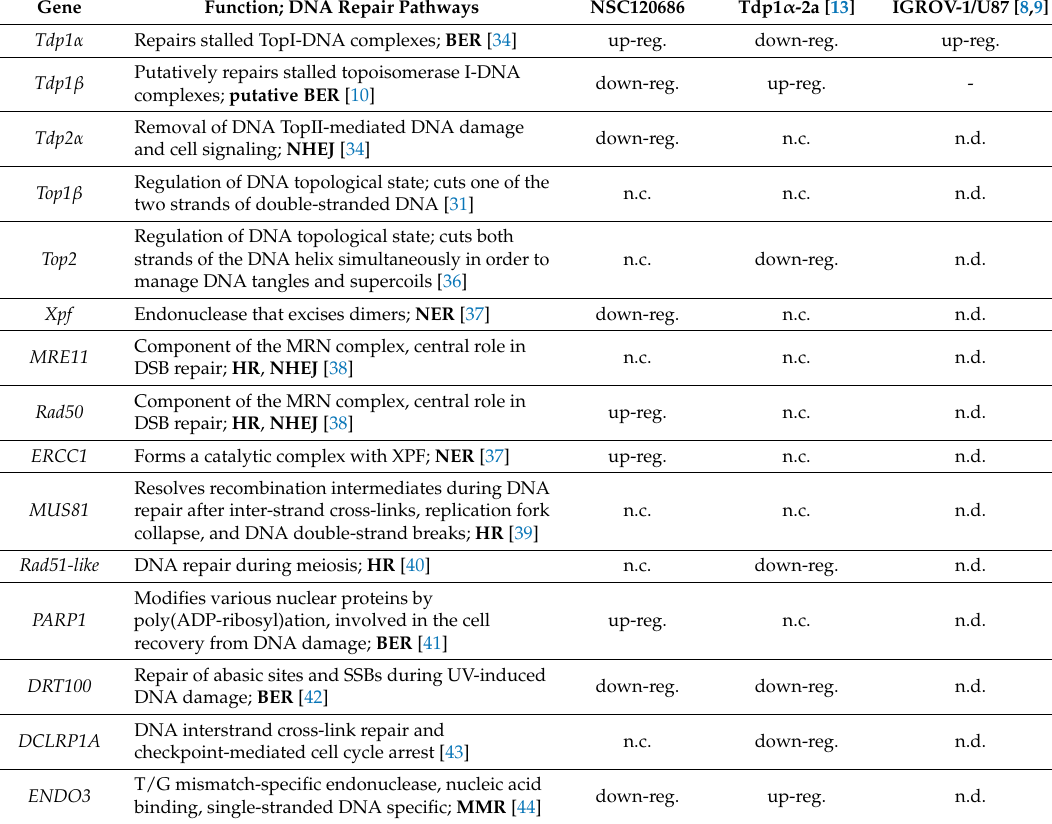
Table 2. Summary of expression profiles of selective genes with functions in DDR in three